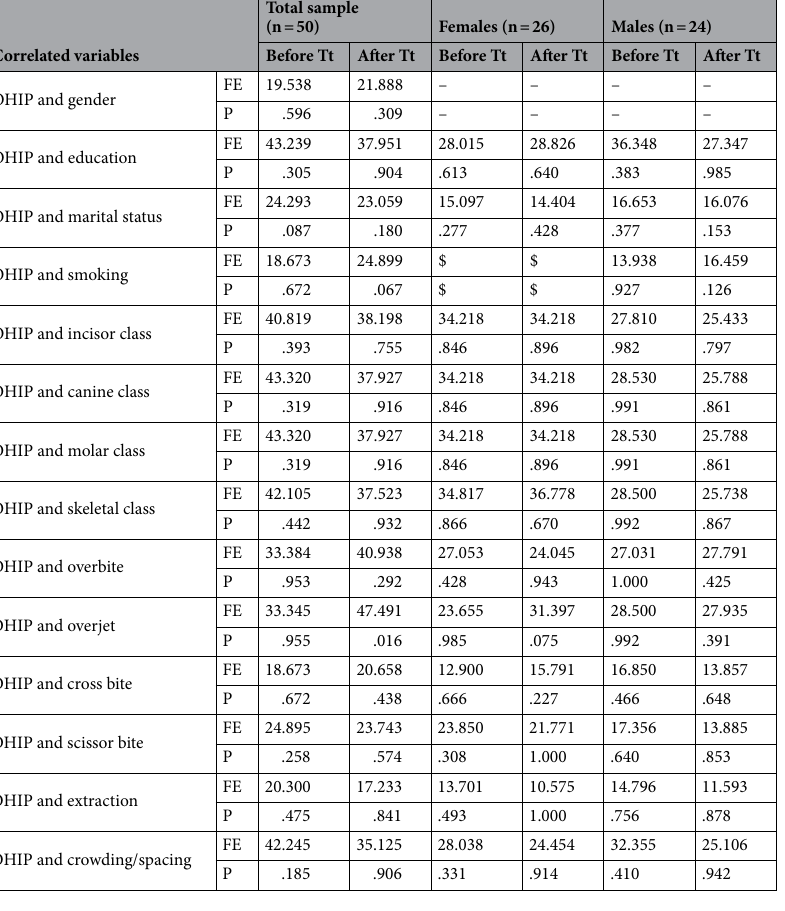
Table 5. Correlations between OHIP scores and different demographic and dental variables before and after treatment among the study population (n = 50, 26 females and 24 males). OHIP = Oral Health Impact Profile scores, Before Tt = Before treatment, After Tt = After treatment, FE = Fisher’s Exact test value, P = Two tailed probability value. $ = Not computed because it is